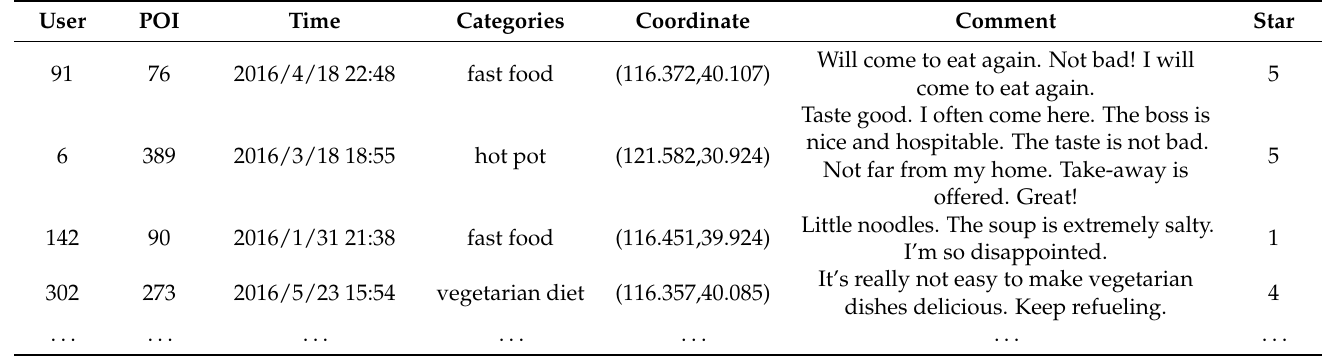
Table 3. Some data of